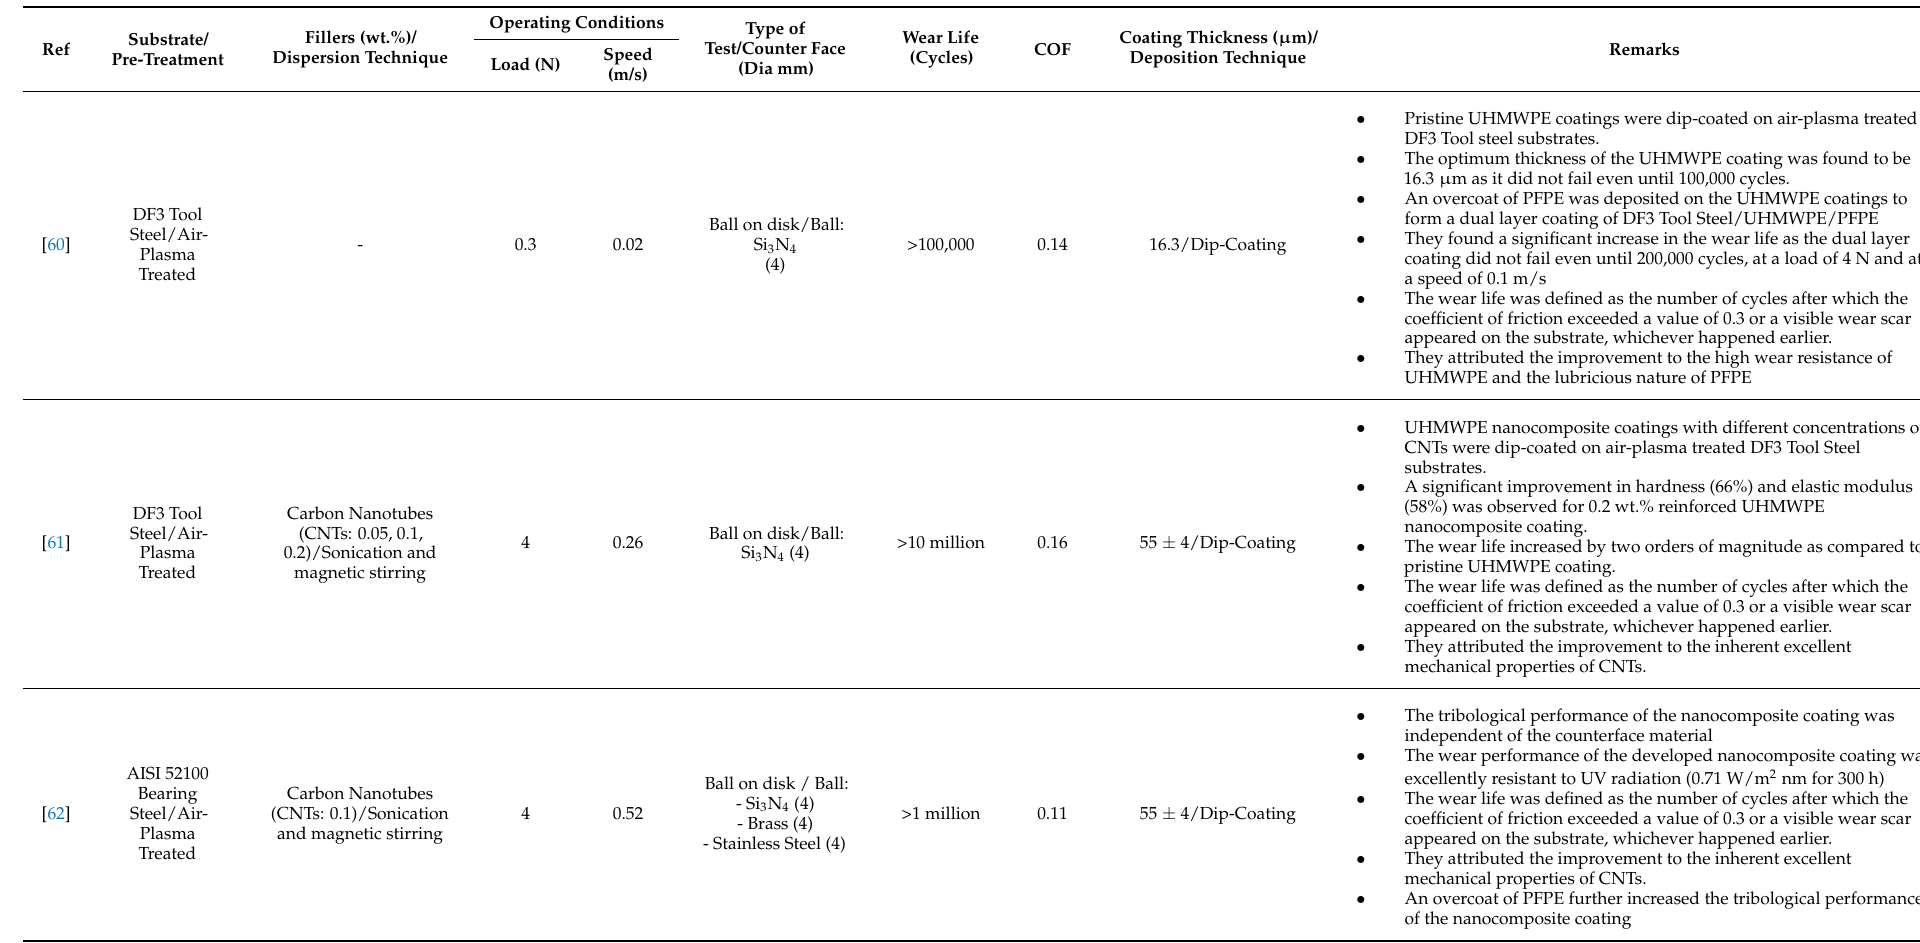
Table 8. Summary of the literature of UHMWPE coatings for mechanical bearing